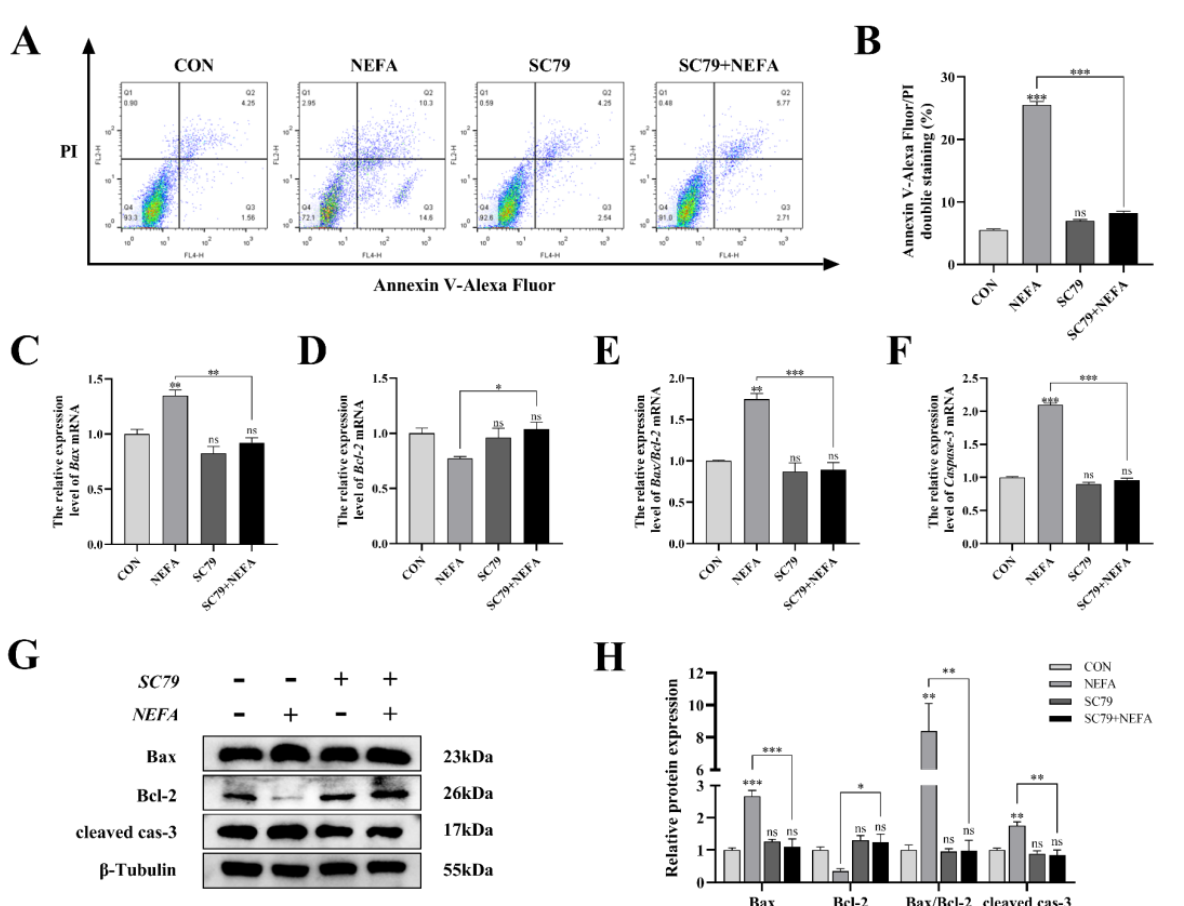
Figure 7. AKT activator SC79 decreased NEFA − induced apoptosis in BGCs. Experiments were performed after NEFA treatment of BGCs for 24 h with or without SC79 pretreatment for 2 h. ( A , B ) Flow cytometry detected the apoptosis of BGCs. ( C – F ) The mRNA levels of Bax, Bcl − 2, and Caspase − 3 were determined using qRT − PCR. ( G , H ) The apoptosis − related proteins Bax, Bcl − 2, and Caspase − 3 were analyzed by Western blot. The quantification of the relative protein levels (performed using Image J) is shown under the band (protein/ β − Tubulin). This experiment was repeated 3 times, and data are expressed as mean ± standard errors of the mean (SEM), * p < 0.05; ** p < 0.01; *** p < 0.001; ns, not significant.